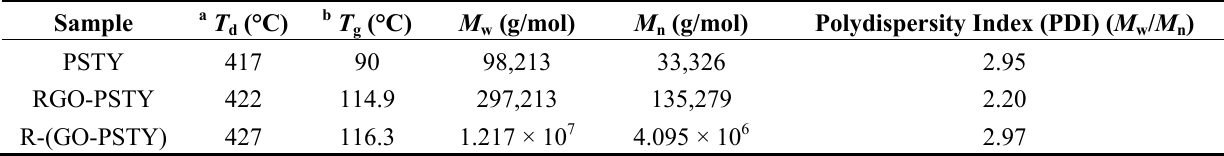
Table 1. Summary of the thermal behavior data obtained from TGA and DSC measurements.